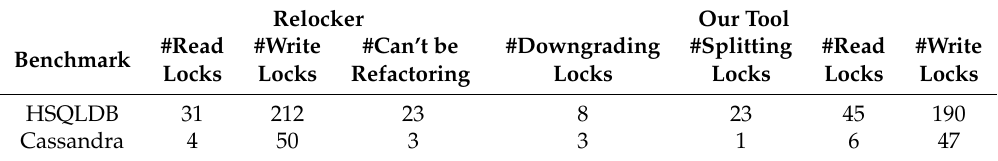
Table 3. Comparison between Relocker and our